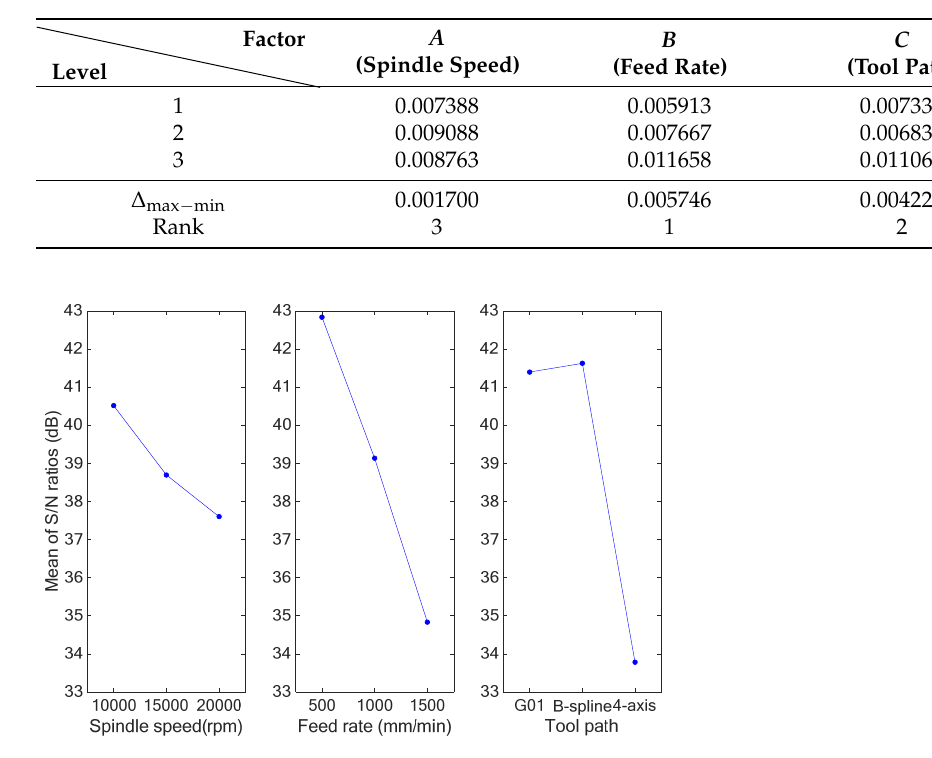
Table 12. ANOVA for the profile errors.